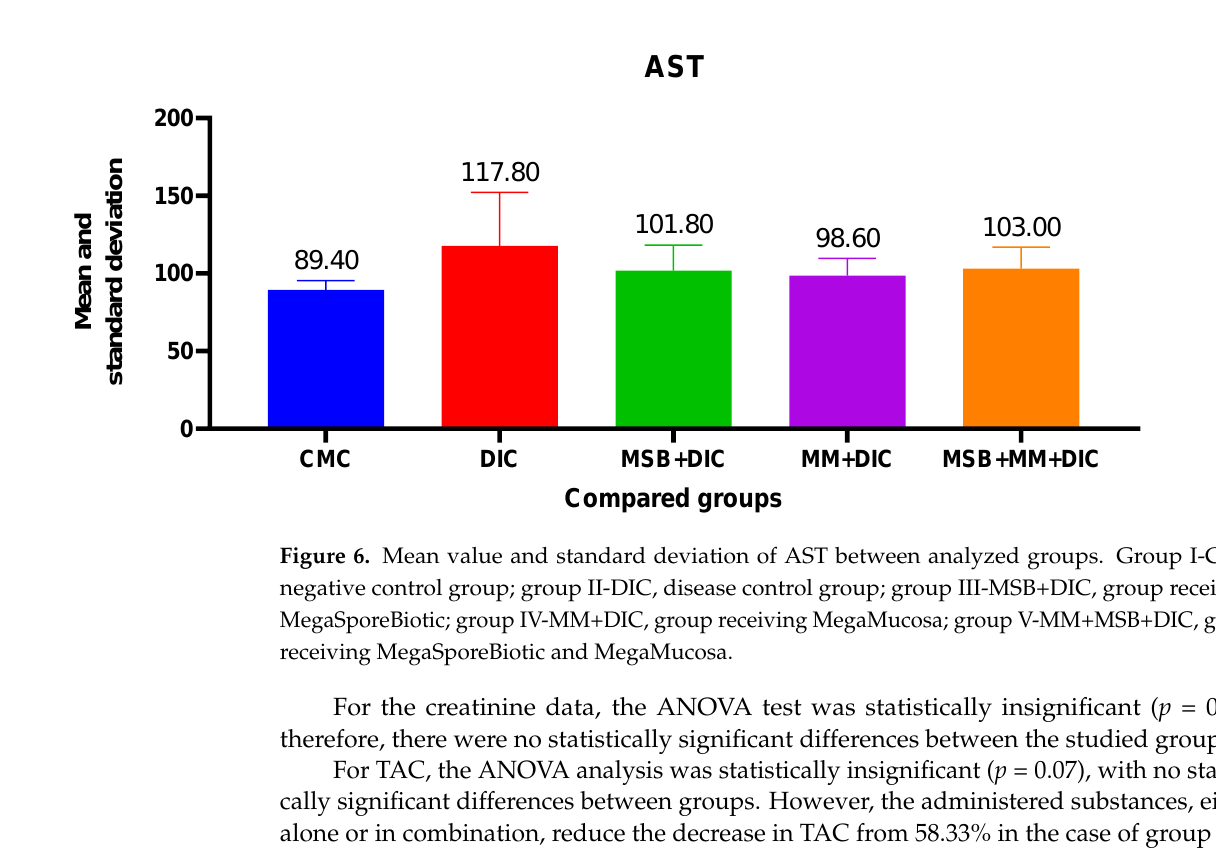
Figure 5. Mean value and standard deviation of ALT between analyzed groups. Group I-CMC, neg- ative control group; group II-DIC, disease control group; group III-MSB+DIC, group receiving Meg- aSporeBiotic; group IV-MM+DIC, group receiving MegaMucosa; group V-MM+MSB+DIC, group receiving MegaSporeBiotic and MegaMucosa.